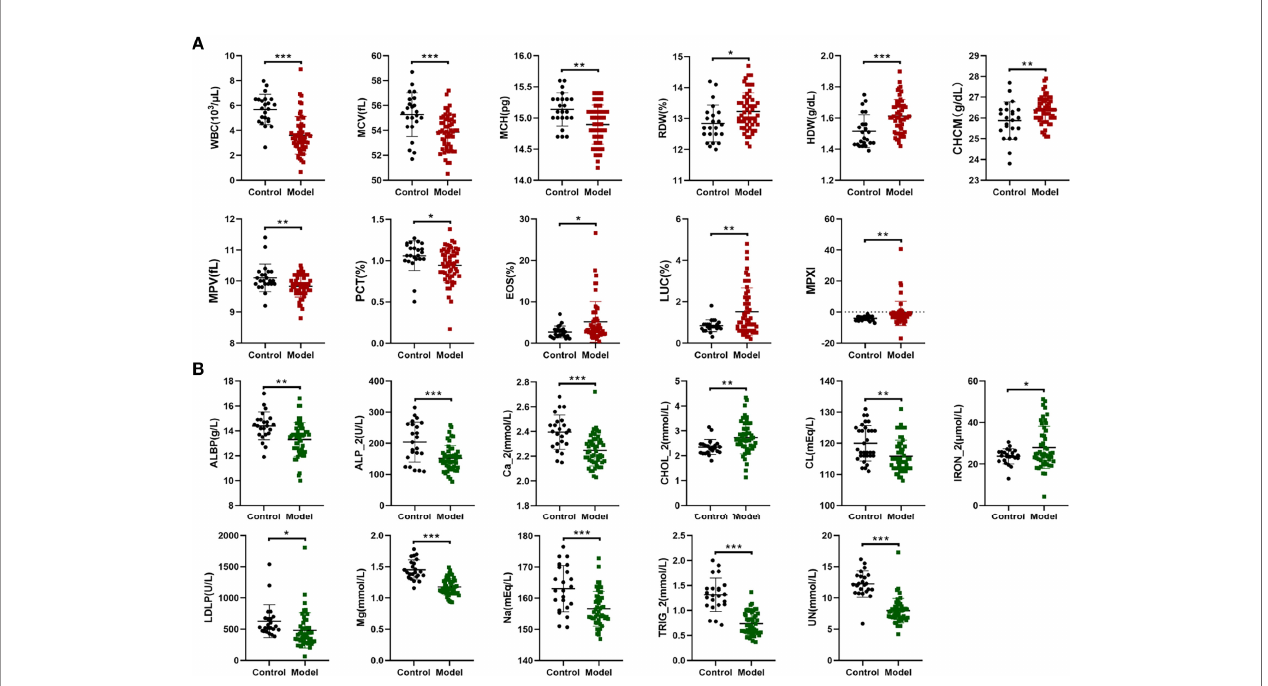
FIGURE 4 | Complete blood count and biochemical analyses. (A) Differential complete blood count indicators between the control group and the damp-heat syndrome group. (B) Differential biochemical indicators between the control group and the damp-heat group. Control: healthy mice (n = 23), Model: mice with damp- heat syndrome (n = 54). *p < 0.05, **p < 0.01, ***p < 0.001.